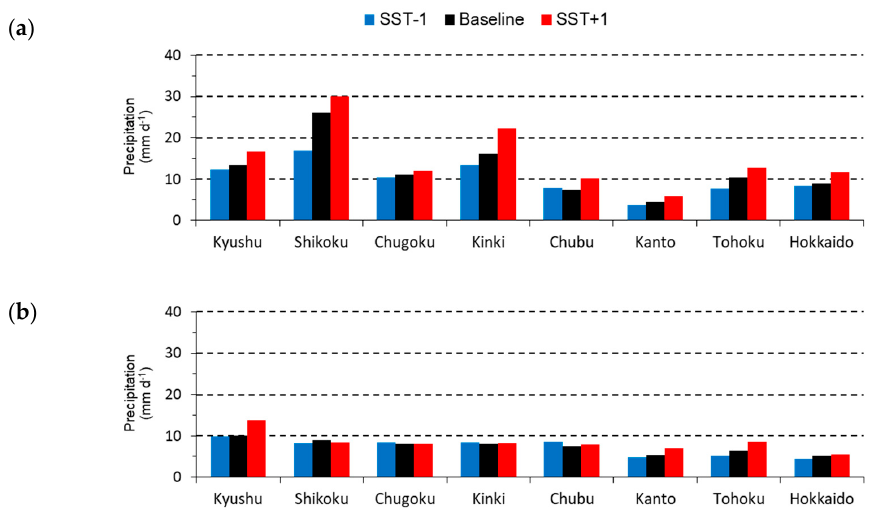
Figure 7. Mean daily precipitations averaged for the meteorological observatories in each region during ( a ) 1 to 15 and ( b ) 16 to 31 August 2014 in the sensitivity study on SST.